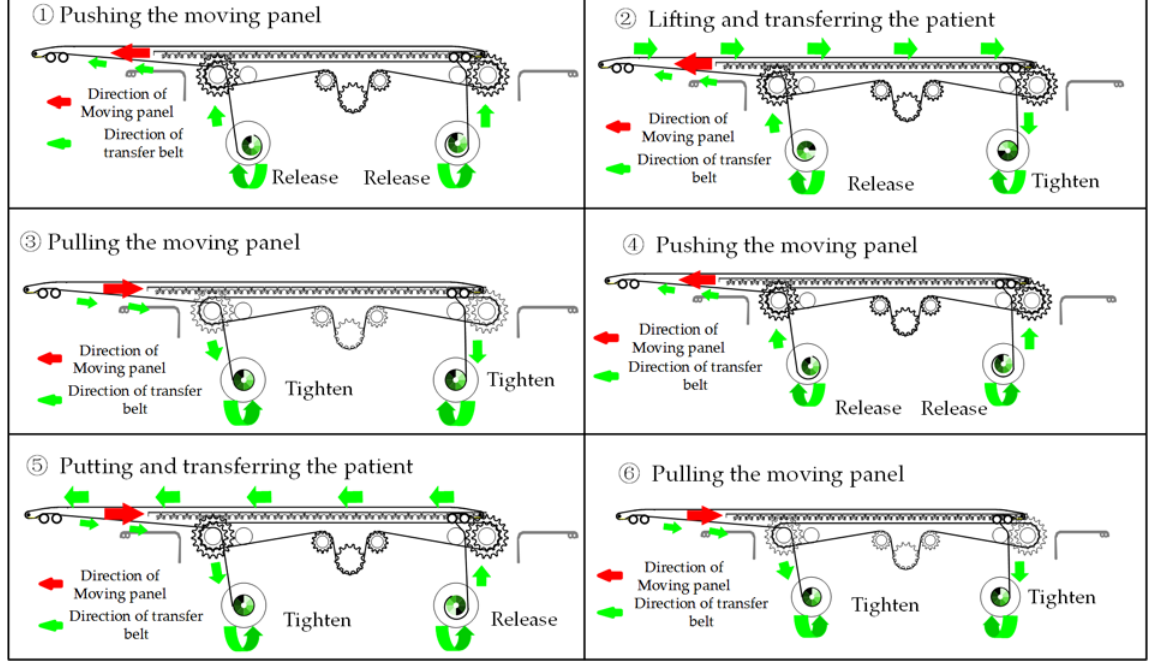
Figure 16. The whole flow chart of patient transfer on the left.